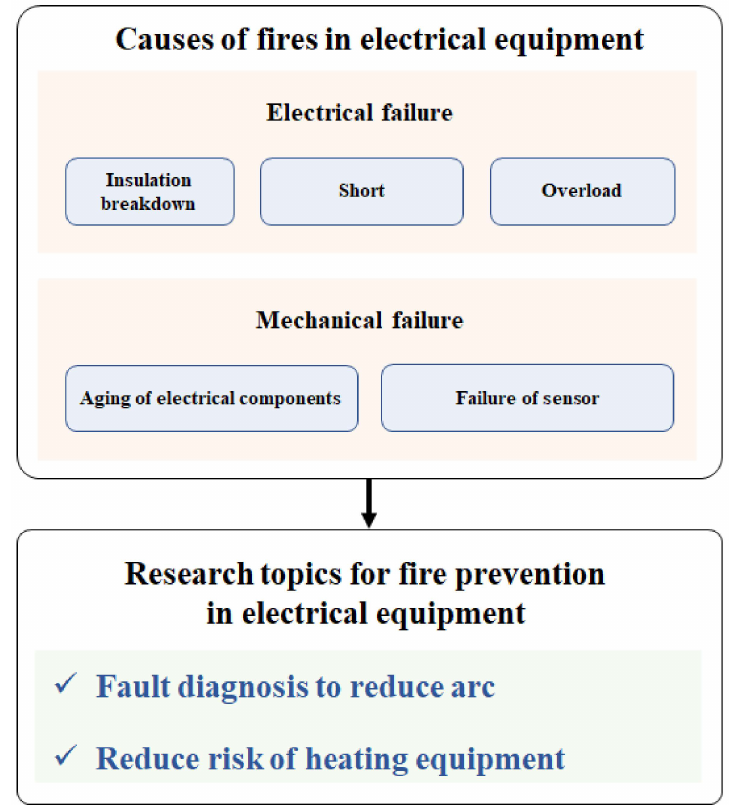
Figure 8. Research trends for fire prevention in electrical